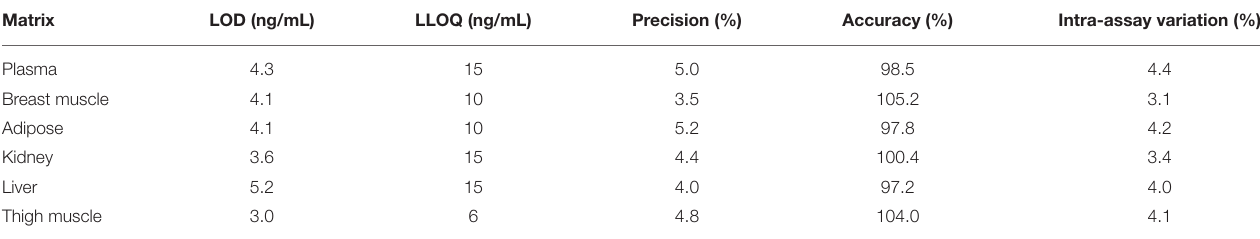
TABLE 1 | Sensitivity, precision, and accuracy parameters for the high-performance liquid chromatography analytical method used to measure meloxicam concentrations in various matrices from chickens following meloxicam dose administered to laying hens.